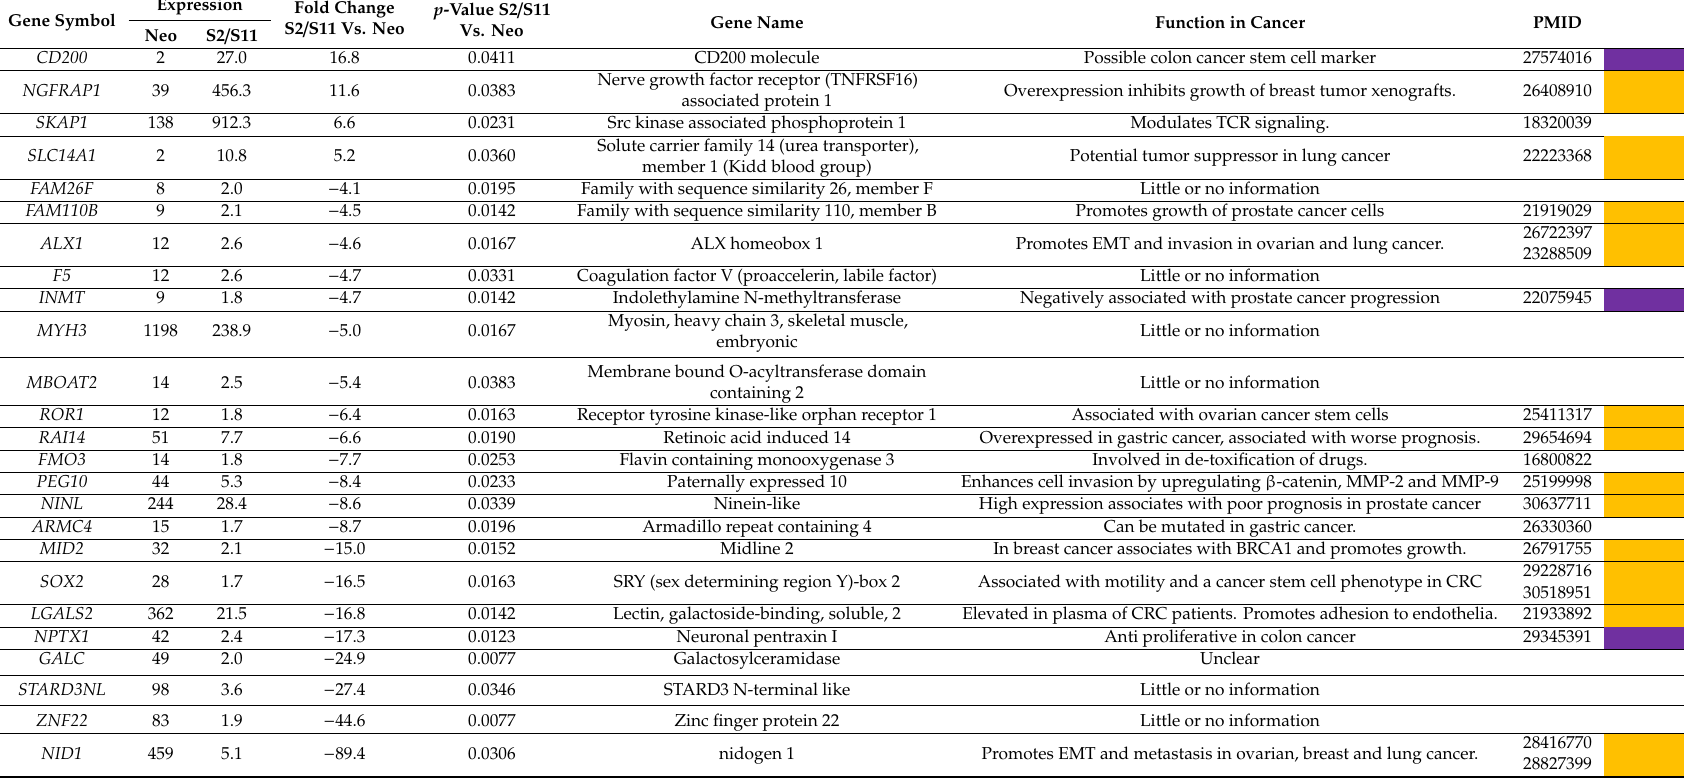
Table 3. Genes highly modulated by B4GALNT2 in LS174T